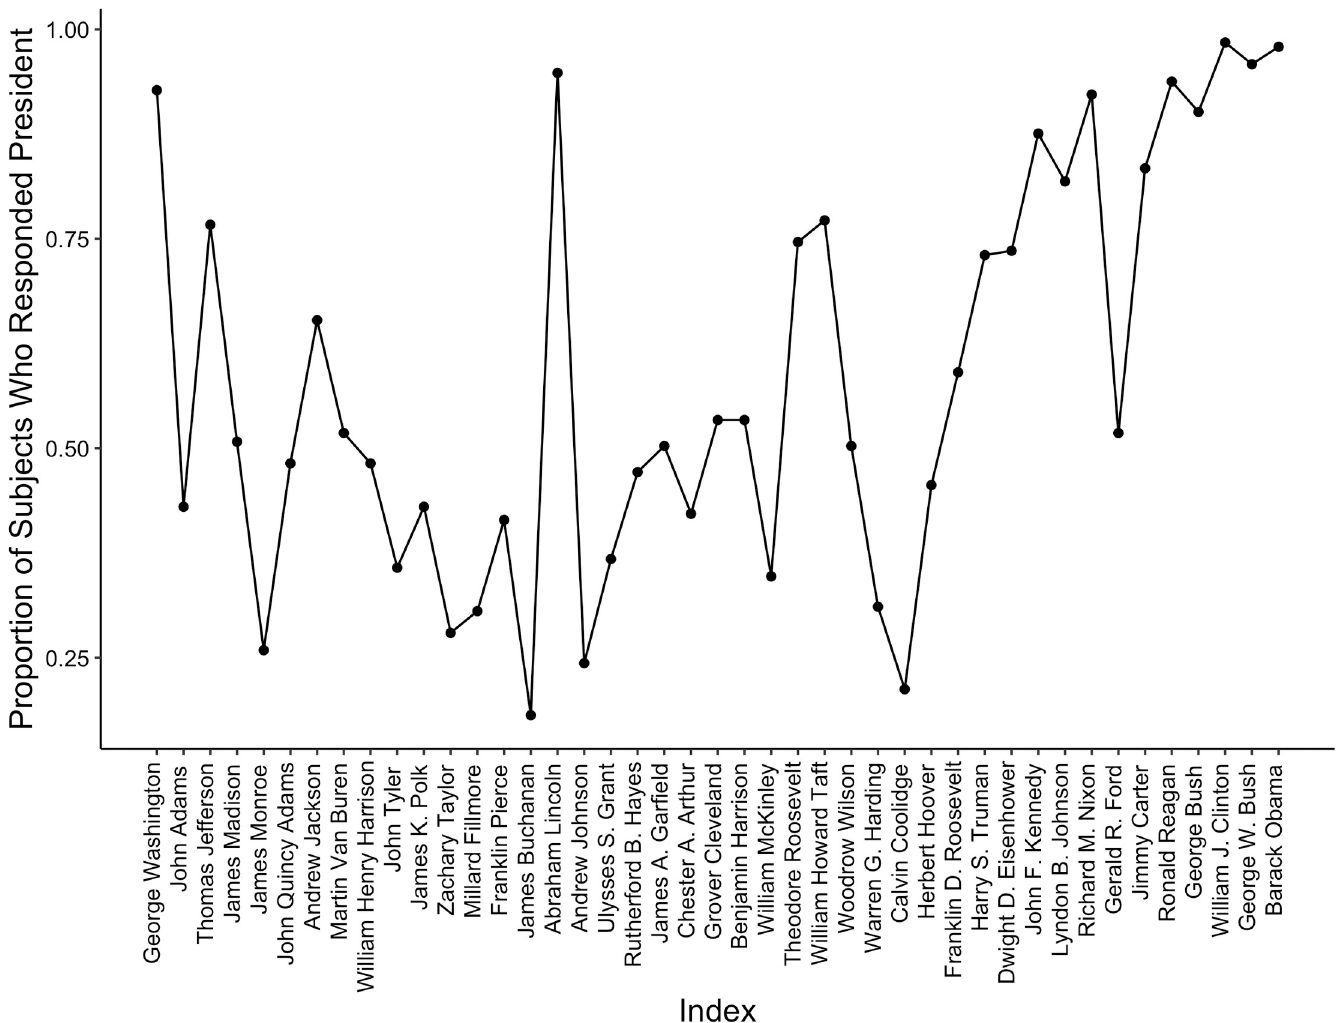
Fig 1. Serial position curve showing the proportion of subjects who responded “president” to each president’s image in Experiment